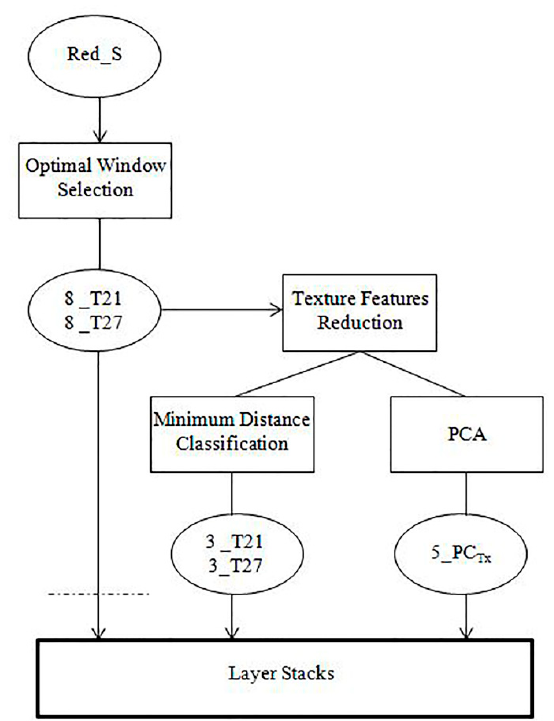
Figure 8. Texture analysis workflow. 8_T21 and 8_T27 are the 8 texture variables available for each selected window size (21 and 27). 3_T21 and 3_T27 are 3 texture variables extracted from the 8 available for each selected window size (21 and 27) with a minimum distance classification. 5_PCTx are the variables resulting from the Principal Component Analysis (PCA) on the 8_T21 and 8_T27 together. The dotted line represents the PCA computed on all variables (RGB orthophotos, NDVI map and texture variables).